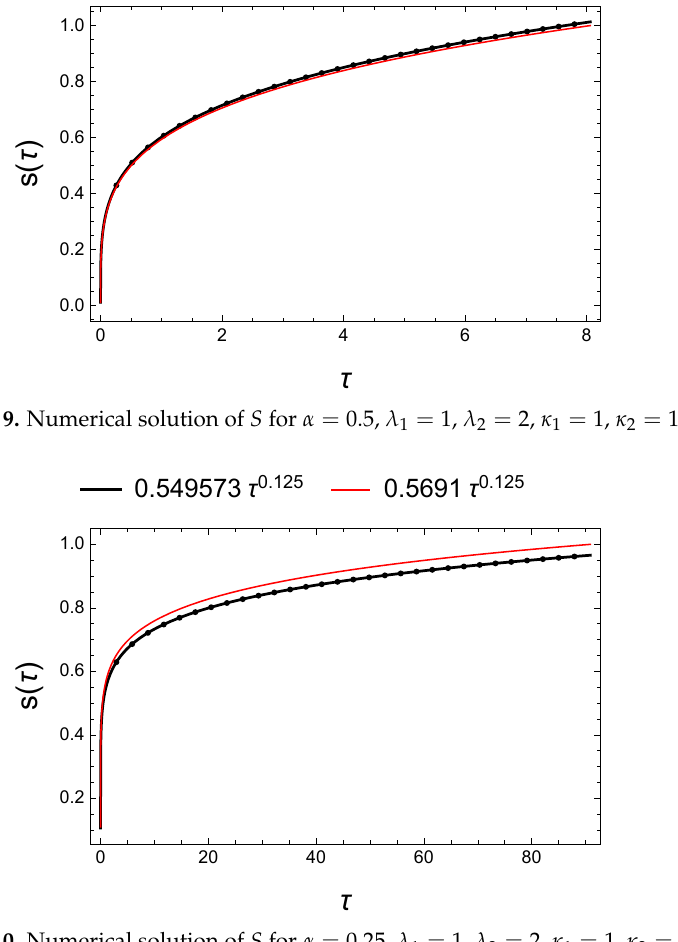
Figure 10. Numerical solution of S for α = 0.25, λ 1 = 1, λ 2 = 2, κ 1 = 1, κ 2 = 1.